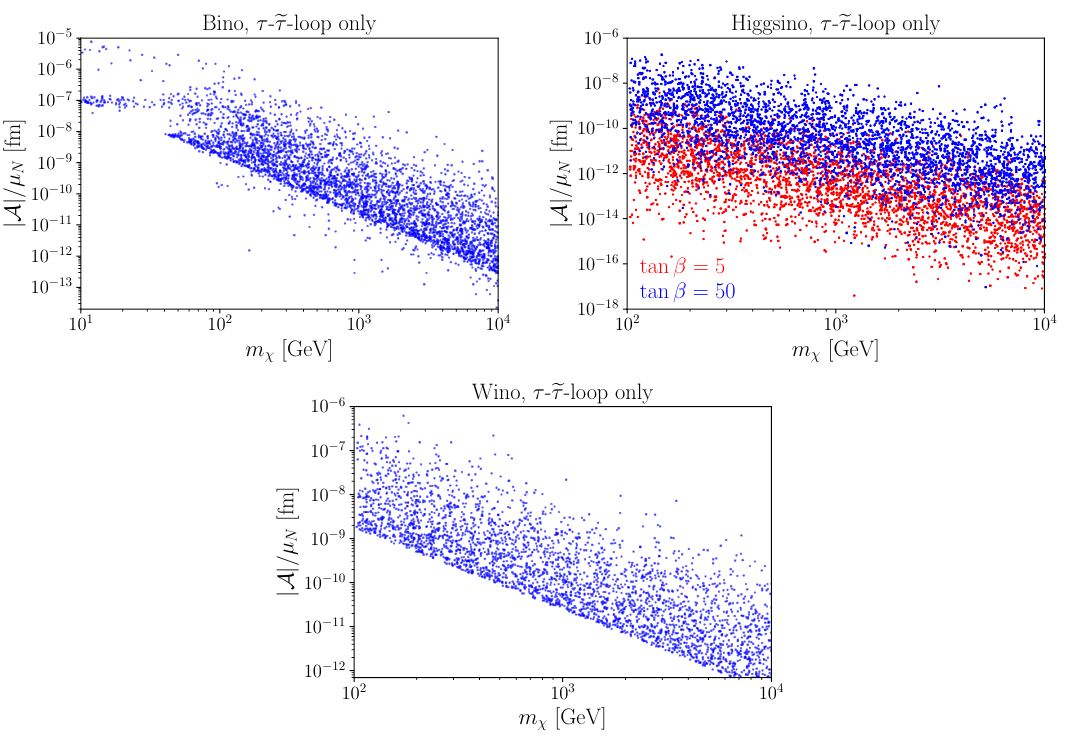
Figure 5. Anapole moment (normalized to the nucleon magneton) for simplified MSSM scenarios with pure bino (top left), pure higgsino (top right), and pure wino (bottom) lightest neutralino, coupling only with the tau and staus. For details, see subsection